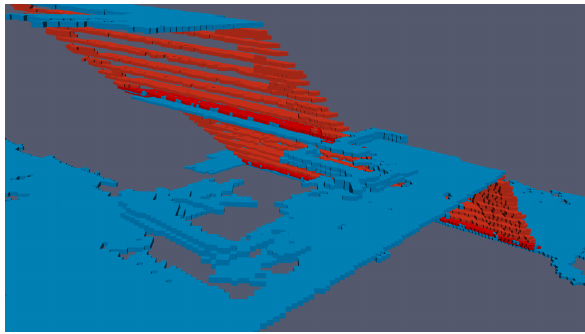
Figure 7. Region grown surface containing furniture as a